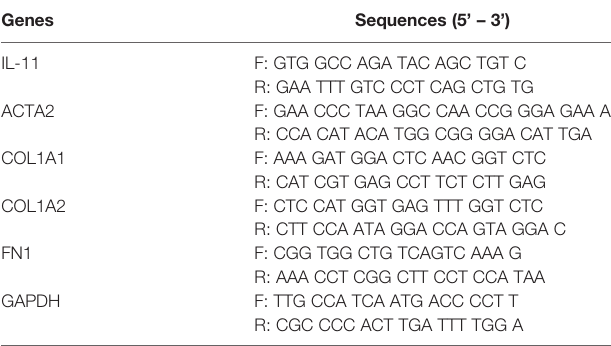
TABLE 3 | Primer Sequences of